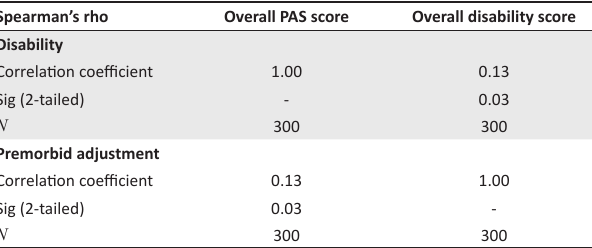
FIGURE 3: Scatter diagram showing the relationship between disability and premorbid adjustment. TABLE 3: Correlation between disability and premorbid adjustment.